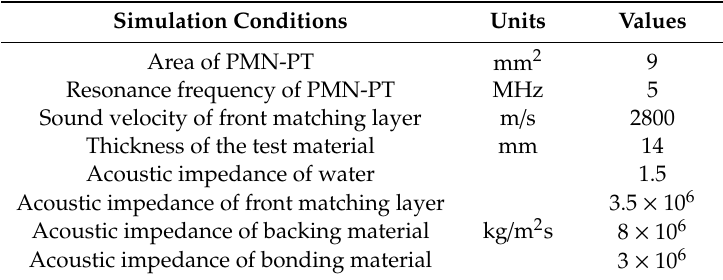
Table 3. Simulation conditions of the KLM model.